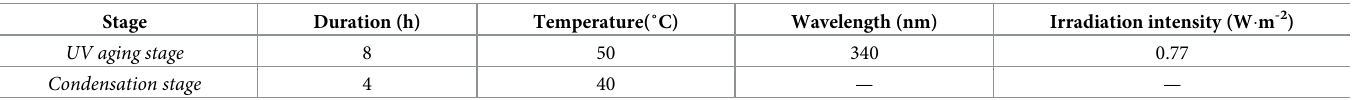
Table 2. UV-accelerated aging test